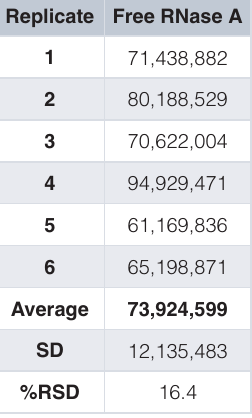
Table 4. Total ion abundance for free RNase A in samples that contained no added deoxyoligonucleotide. Data